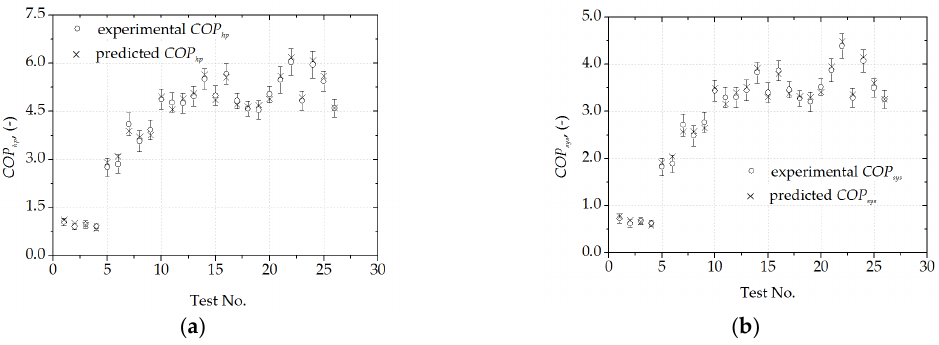
Figure 5. The predicted COP s, experimental COP s and their uncertainties: ( a ) COP hp , ( b ) COP sys .